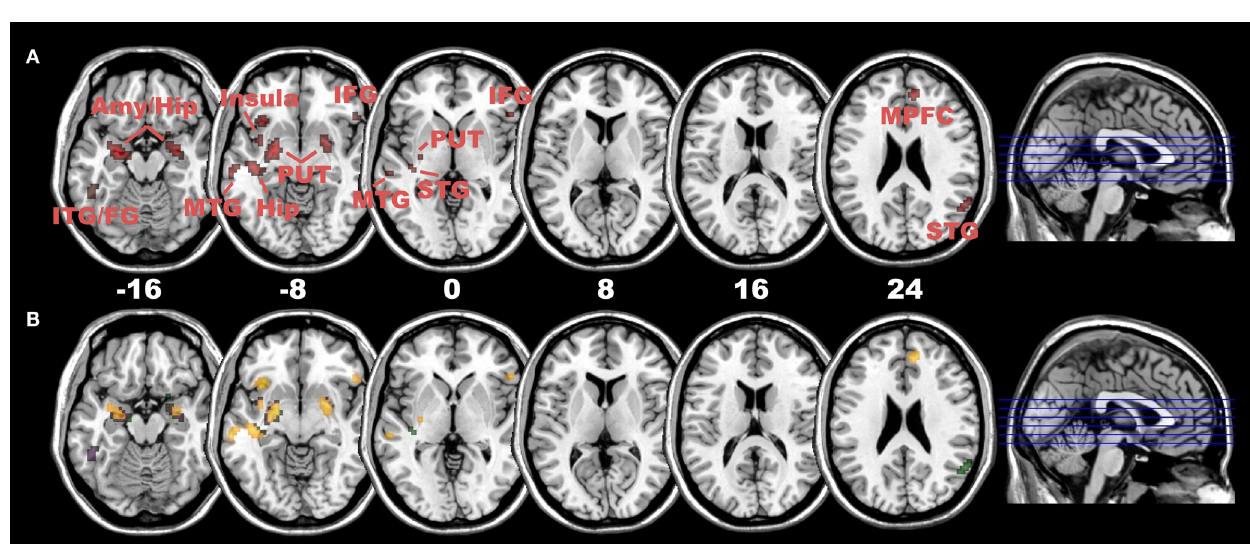
Figure 4 | Positive connectivity with right DLPFC in children. (A) Positive connectivity (red colour) with right DLPFC mainly in subcortical and emotional areas (including amygdala/hippocampus and insula) as well as multisensory integration areas (posterior STG), areas of the ventral visual processing stream (including Fusiform Gyrus) and small clusters in prefrontal areas (inferior and medial PFC) in children subjects (at p < 0.005, cluster extent: 10 voxels; Amy, amygdala; Hip, hippocampus; ITG/MTG,STG, inferior/middle/superior temporal gyrus; Put, putamen; IFG, inferior frontal gyrus; MPFC, medial prefrontal cortex). (B) Signifi cant differences in positive connectivity between right DLPFC and left DLPFC in areas depicted in (A) , at p < 0.005 (yellow), p < 0.01 (violet) and p < 0.05 (green, all with a cluster extent of 10 voxels). In children subjects, all areas depict a clear right-sided lateralization pattern in positive